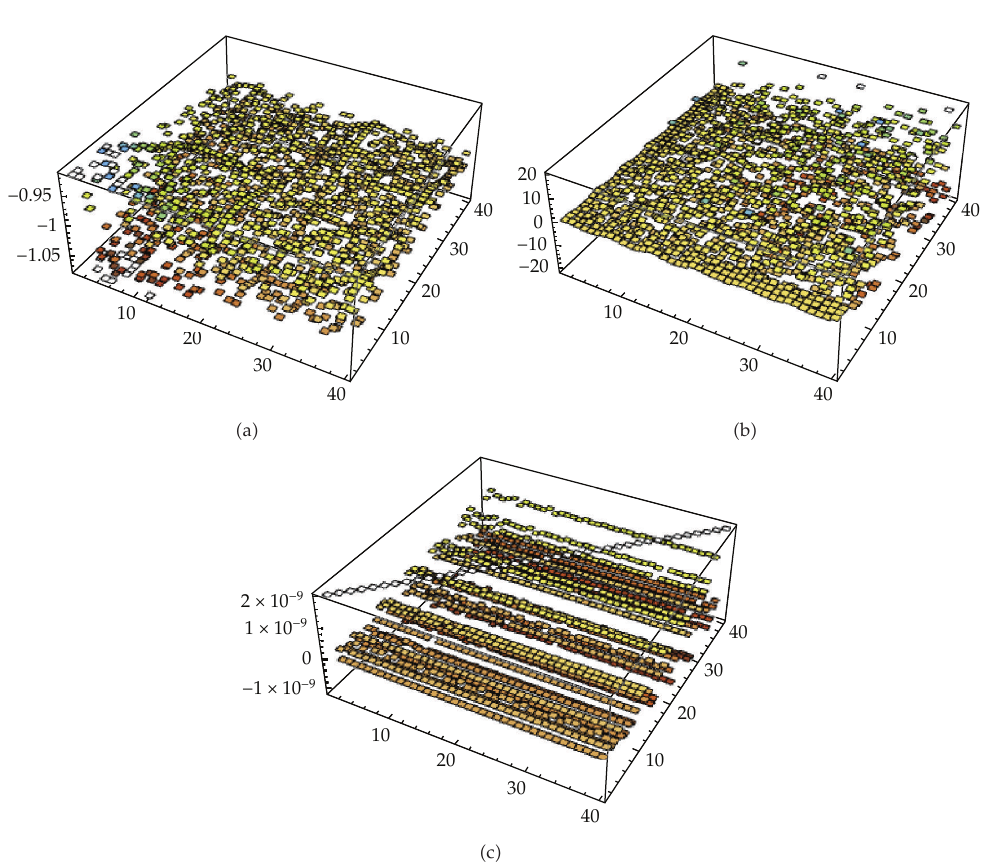
Figure 3: The 3D plot of the structure of the coe ffi cient matrix (cid:4) a (cid:5) in the Test Problem 2, its approximate inverse (cid:4) b (cid:5) by the method (cid:4) 3.1 (cid:5) and their multiplication to obtain a similar output to the identity matrix (cid:4) c (cid:5)